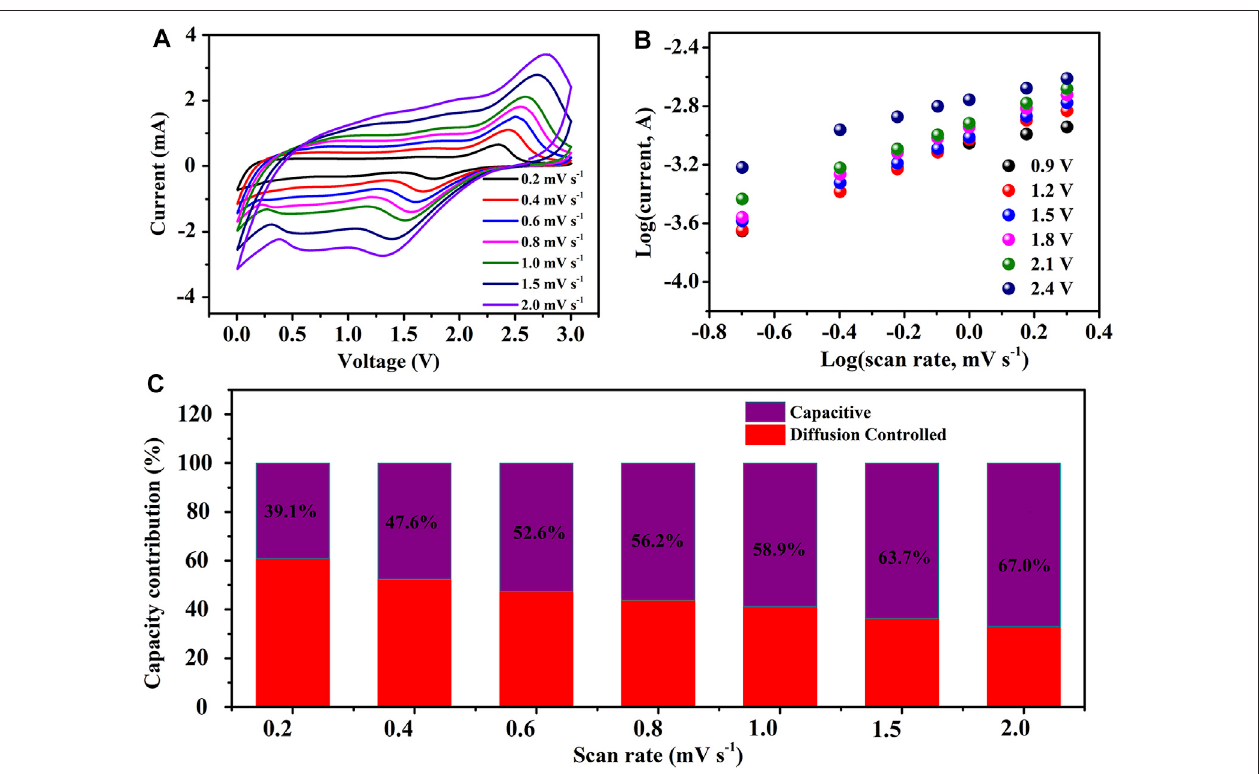
FIGURE 7 | Electrochemical behaviors of F-MoS 2 @NC as anode of LIBs: (A) CV curves of F-MoS 2 @NC-0.8 electrode at different sweep rates. (B) Linear relationship between log( i ) and log( v ) of F-MoS 2 @NC-0.8 electrode at different voltage. (C) Ratios of capacitive and diffusion controlled contributions at different sweep